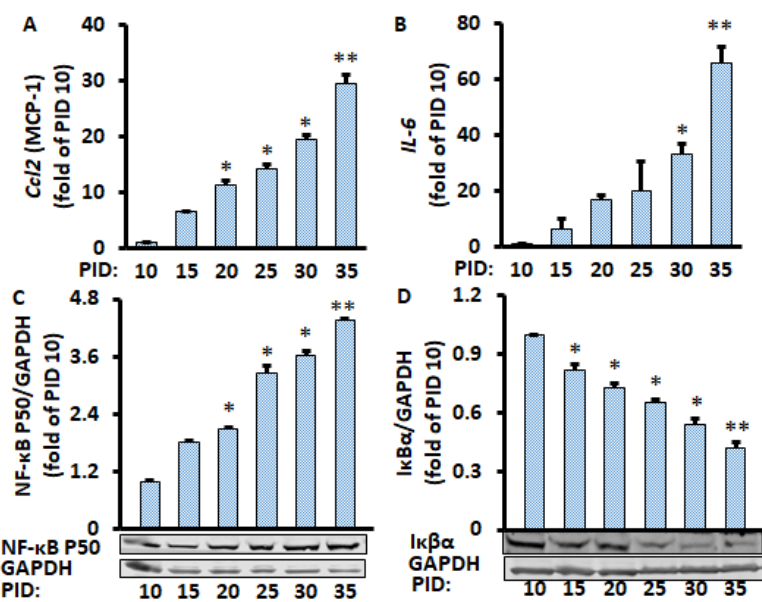
Figure 3. Time course of changes in gene and protein levels during the 35 days of differentiated adipocytes in the unconditioned medium. mRNA of Ccl2 ( A ) and IL-6 ( B ) were measured by RT-PCR, and protein levels of NF- κ B p50 ( C ) and I κ B α ( D ) were measured by Western blot and normalized by EEF2 and GAPDH, respectively. Data were analyzed using one-way ANOVA, and significant differences were further analyzed using Tukey’s test; * p < 0.05, ** p < 0.01 compared to PID 10.